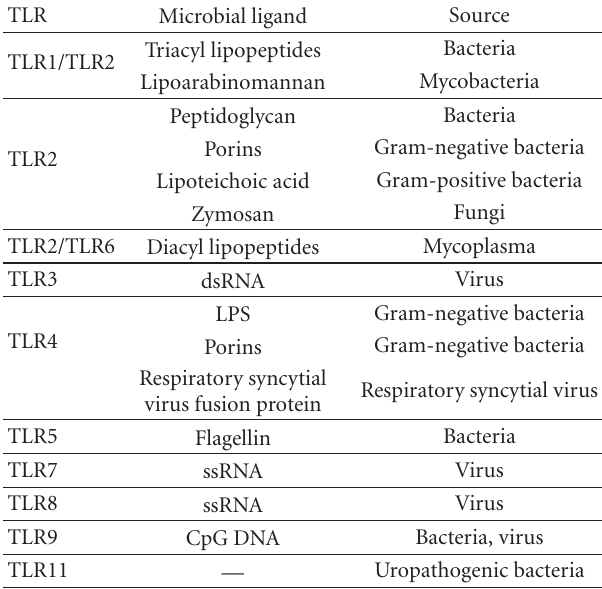
Table 1: Some TLR agonists from bacteria, viruses, and fungi (modified from [67,